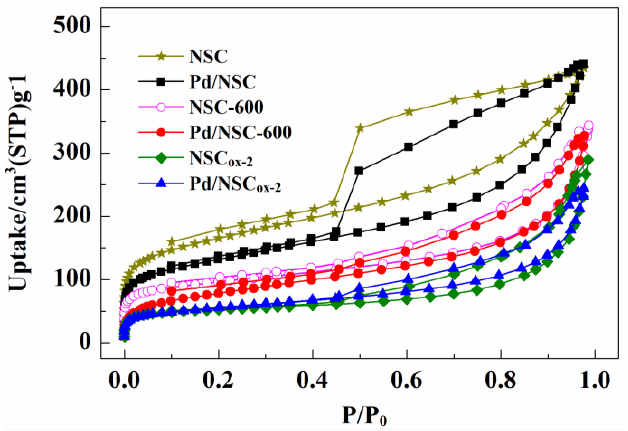
Figure 4. Nitrogen adsorption/desorption isotherms of the three carbon samples and the corresponding catalysts. Table 1. Textural and structural properties of the carbon samples and the corresponding catalysts.